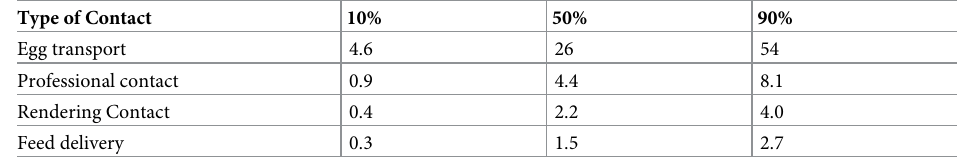
Table 5. Relative reduction (in %) of reproduction number R 0, m of the VPI compartment farms as function of the reduction in transmission probability (10, 50, 90%) of a specific route, due to biosecurity measures within the